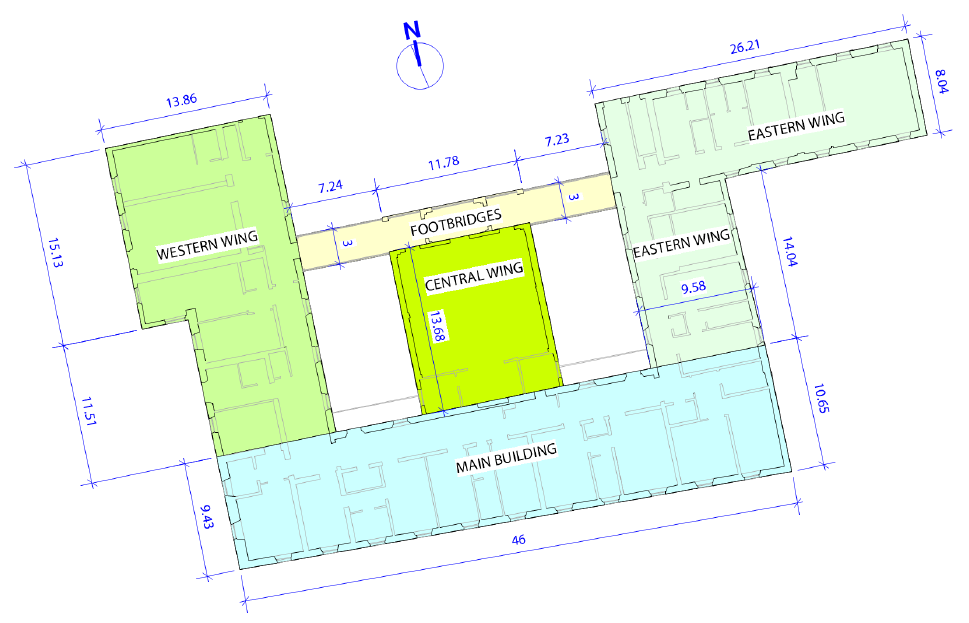
Figure 2. Plan of the “Padiglione Lodi” building